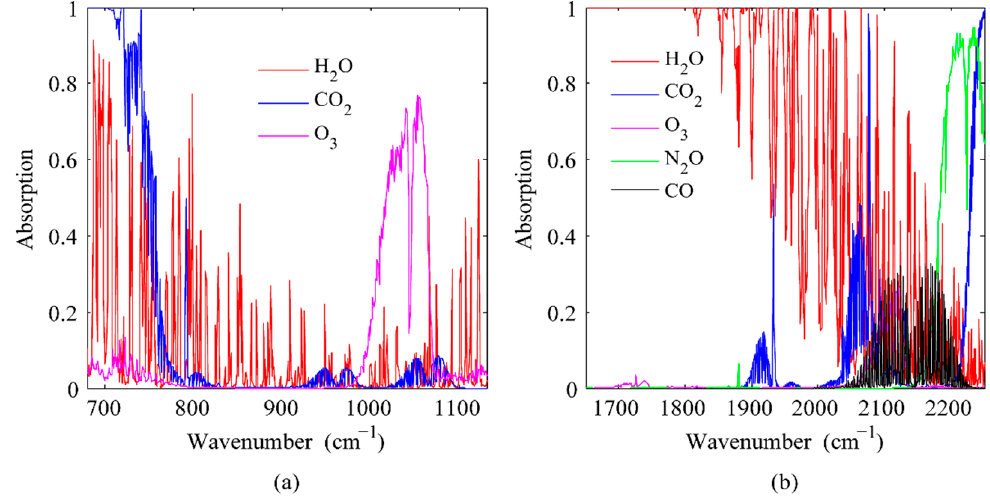
Figure 2. The absorption spectra of the main atmospheric components at sea level: ( a ) Long wave infrared; ( b ) Medium wave infrared.